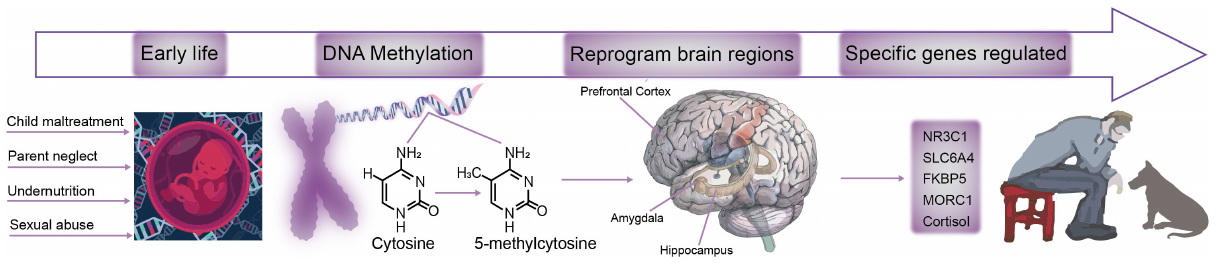
Frontiers in Cell and Developmental Biology |